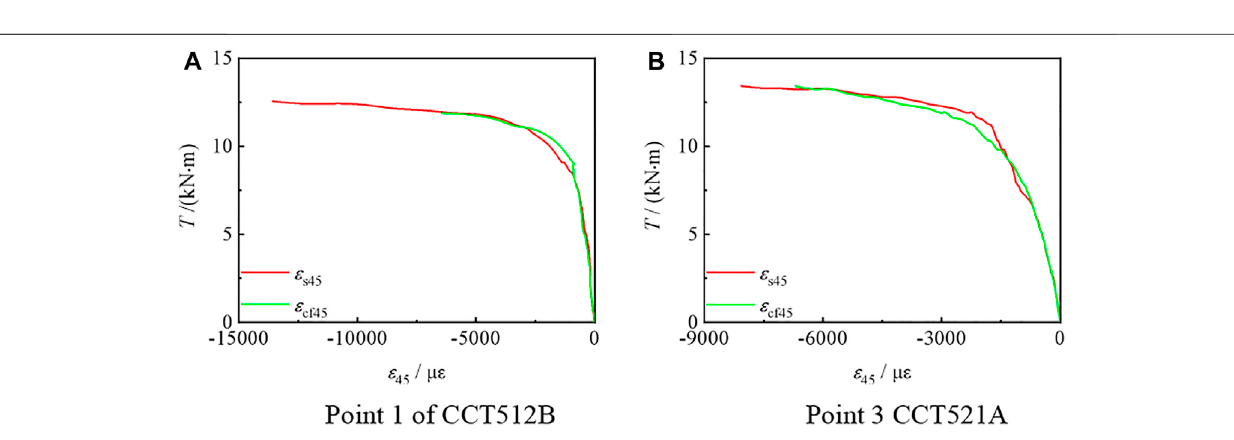
Frontiers in Materials |